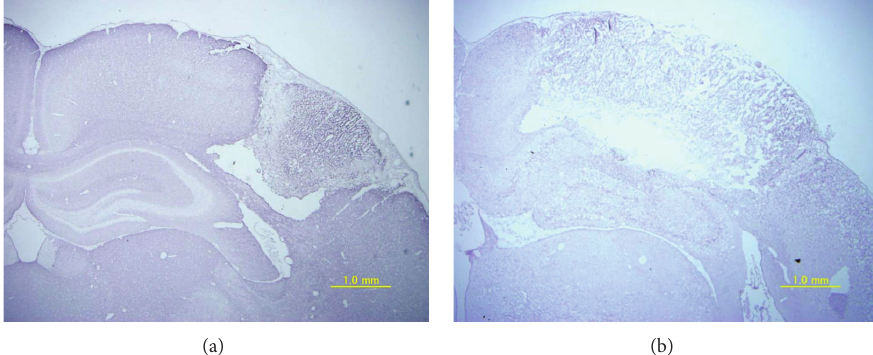
Figure 1: Photomicrograph of rat brain 7 days after photochemical infarction. Edaravone-administered (a) and control (b).